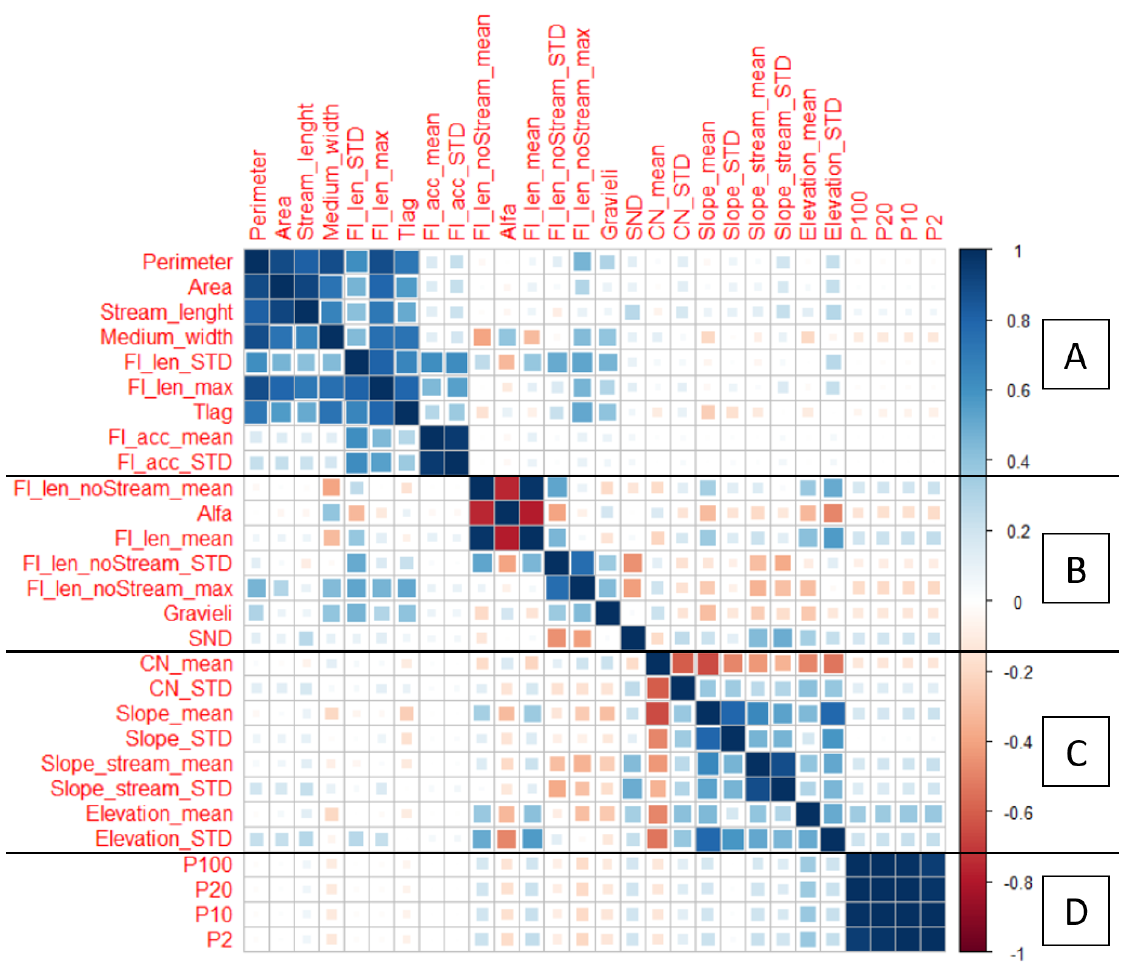
Figure 2. Visualization of the correlation coefficients between individual parameters for all catchments regardless of size category. A negative correlation is shown in red, and a positive correlation is shown in blue. The stronger the correlation between two parameters, the darker and larger the symbol. Parameters in correlation are grouped. The main groups ( A – D ) are separated by a black line. A description of the parameters is provided in Table 2.